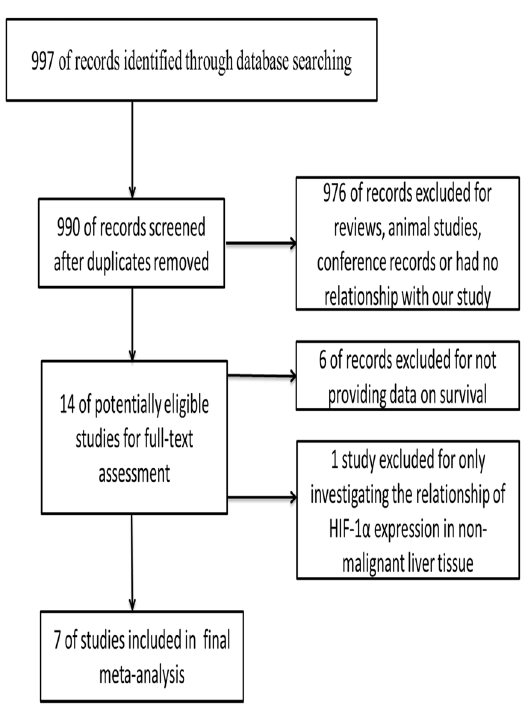
Figure 1. Flow diagram indicating the process of selecting articles for